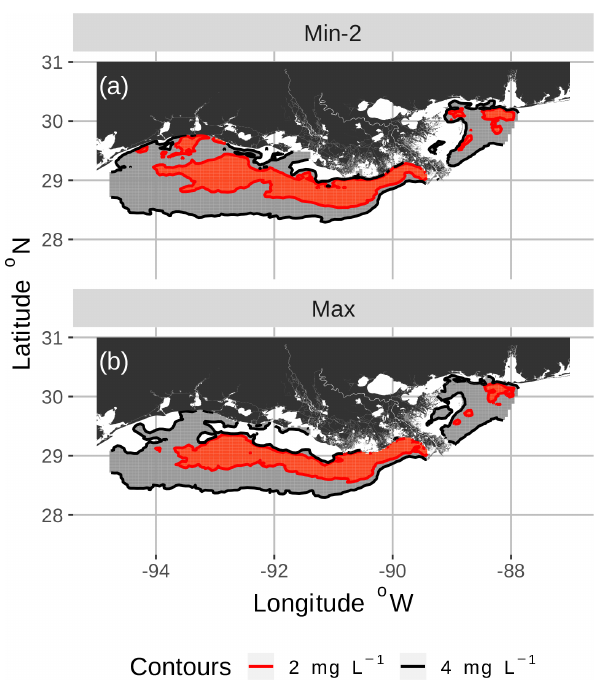
Figure 3. Spatial maps of bottom DO showing the 2 and 4mgL − 1 contours for two of the eight snapshots from the FVCOM-WASP simulation of 20–30 August 2002. The snapshots are defined in Ta- ble 1. Snapshot Min-2 ( a ; row 2 in the Table) is moderate sublethal area and minimum AUC, and snapshot Max ( b ; row 8 in the Table) is high sublethal area and maximum AUC. Areas in white outside the 4mgL − 1 line are